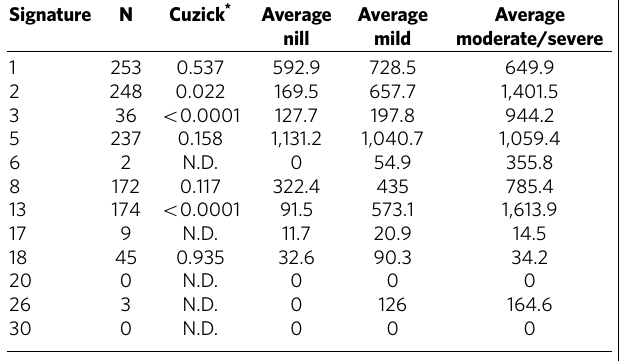
Table 2 | Association of the number of substitutions per signature by lymphocytic infiltrate